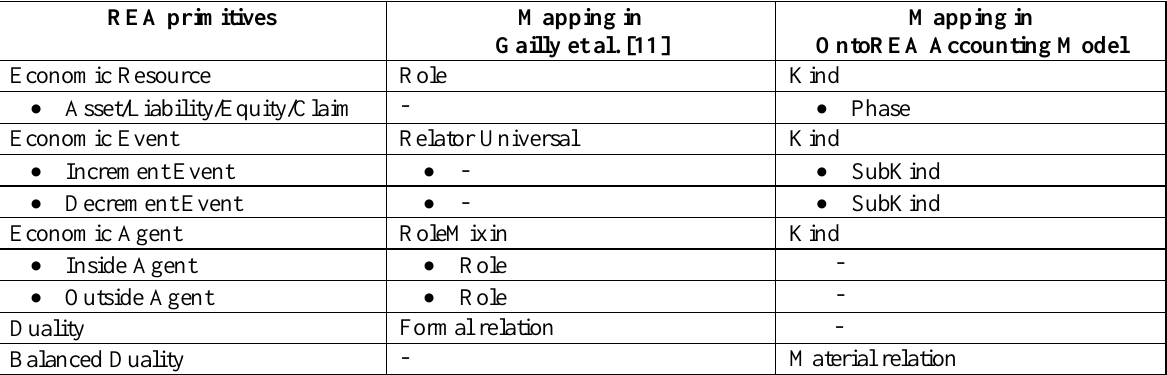
Table 1. Mapping of REA Primitives onto OntoUML constructs REA primitives Mapping in Mapping in Gailly et al. [11] OntoREA Accounting